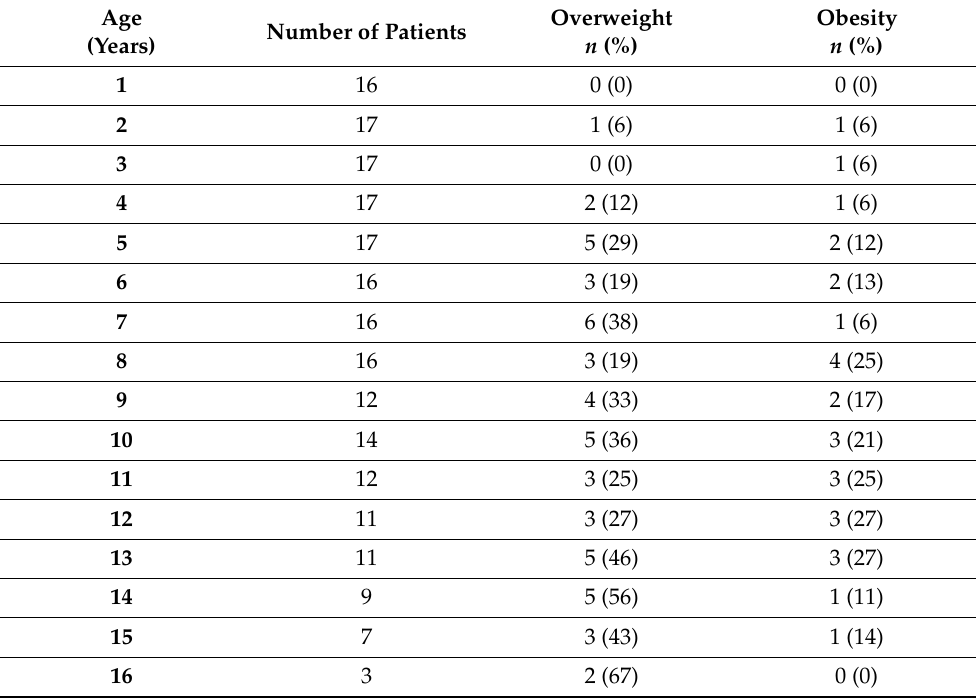
Table 3. Percentage of overweight and obesity from first year to 16 years of age. Overweight Age Number of Patients (Years)